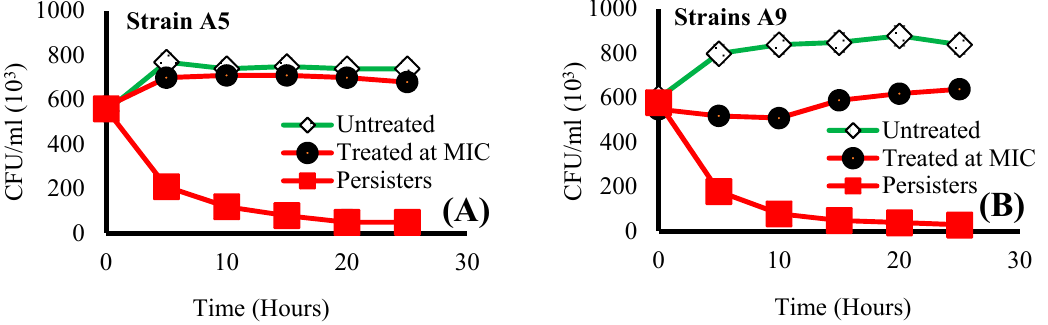
Figure 1. Growth curves of Strains ( A ) A5 and ( B ) A9 as a function of ampicillin treatment. Strains A5 and A9 started with 56 × 10 3 and 58 × 10 3 CFU/mL of viable colonies, respectively. Error bars represent the standard error of the means from a three-biological replicate.